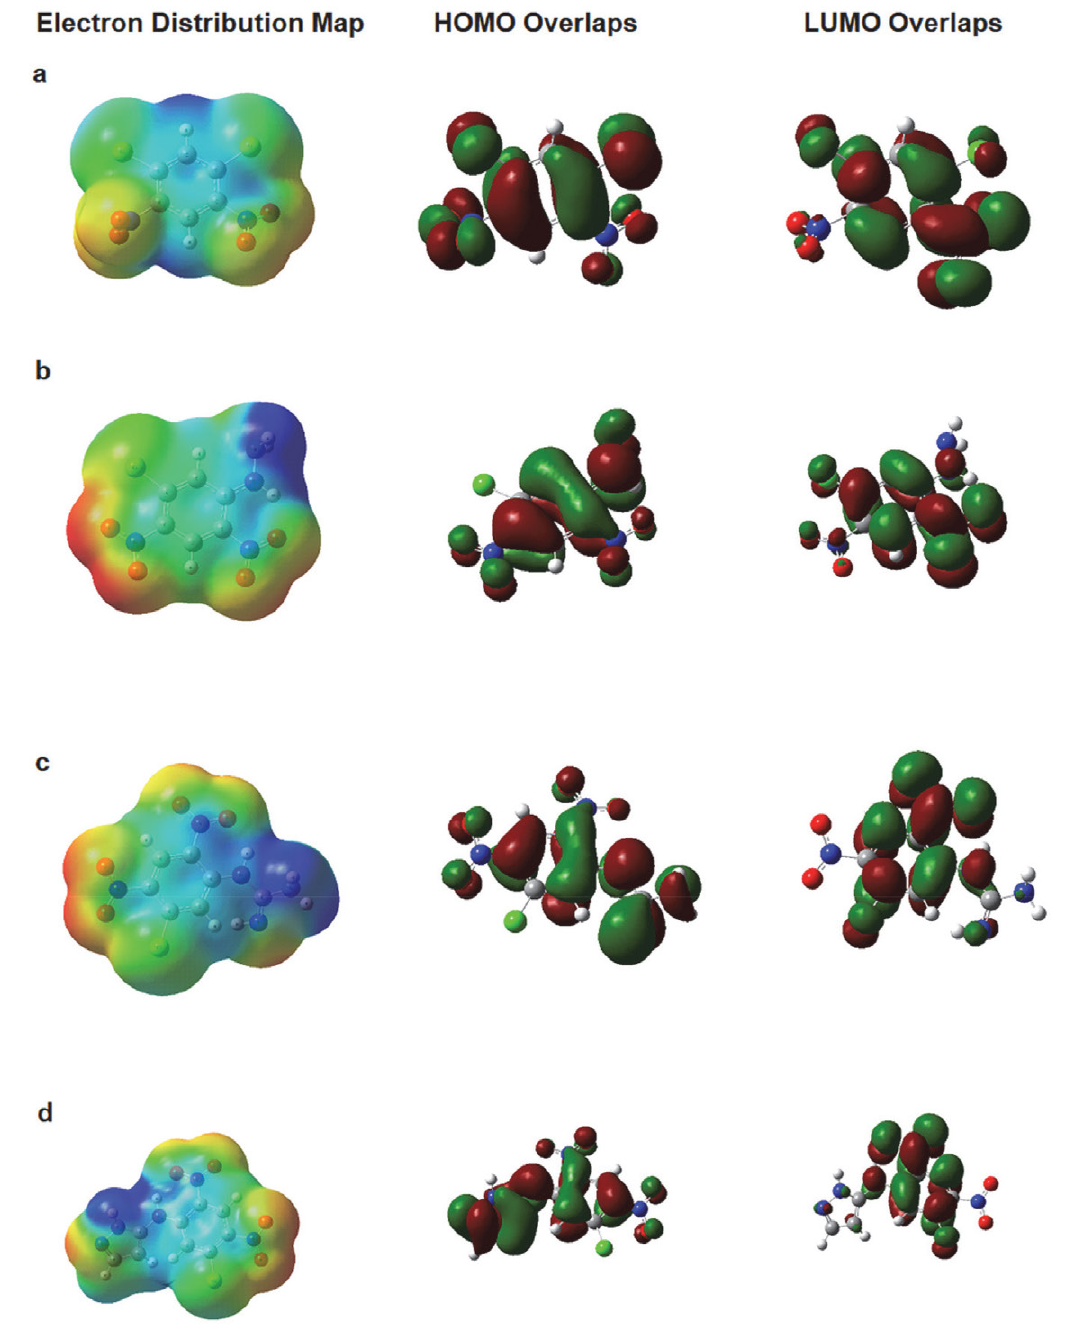
Figure 7. Electron density distribution and HOMO and LUMO images of the energetic molecules prepared, a: 1,3-dichloro-4,6-dinitrobenzene, b: N -(5-chloro-2,4-dinitrophenyl)hydrazine ( 1 ), c: N -(5-chloro-2,4-dinitrophenyl)guanidine ( 2 ), d: N -(5-chloro-2,4-dinitrophenyl)-4-ami- nopyrazole ( 3